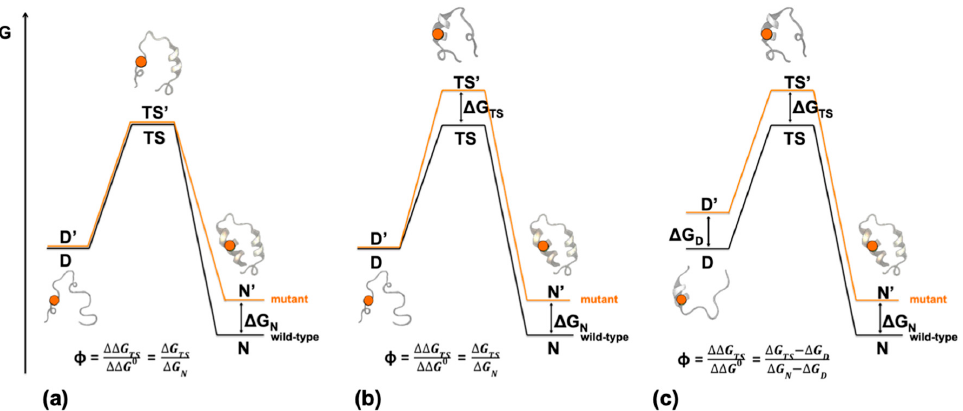
Figure 1. Di ff erent Φ value profiles and related free energy diagrams for a two-state folding reaction of a wild-type (black line) and mutated (orange line) protein. The mutation is highlighted on the structure with an orange circle. ∆ G N , ∆ G TS and ∆ G D refer to the changes in stability upon mutation of the native, transition and denatured states respectively. ( a ) Φ value = 0. Mutation does not a ff ect the structure and the stability of the transition state. The mutated region appears unstructured in the transition state likewise in the denatured state ( ∆ G TS = 0) ( b ) Φ value = 1. The mutation insists in a native-like structured region of the transition state, with ∆ G TS tending to ∆ G N . In both cases, the free energy of the denatured state does not change upon mutation ( ∆ G D = 0). ( c ) The mutation a ff ects the stability of the denatured state. This e ff ect may reflect in an unusual Φ value, i.e., > 1 or <